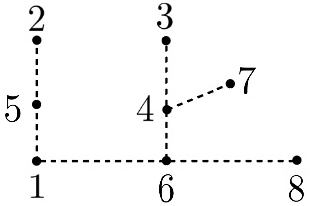
= (cid:8) 1 , { 5 , 2 } (cid:1) (cid:8) 6 , { 4 , 3 (cid:1) 1